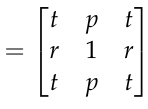
Figure 5. Model for serial detection [22,23]. The trellis of the horizontal detector includes 36 states and six branches in each state, and the trellis of the vertical detector has four states and two input/output branches in each